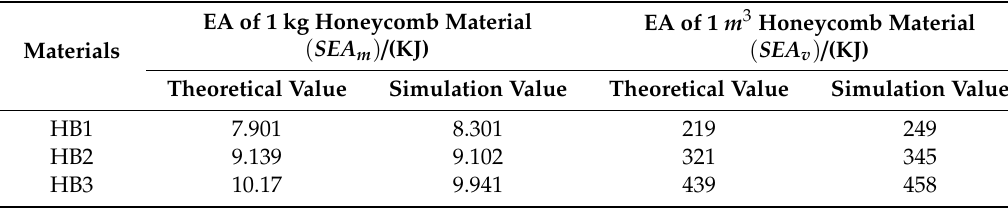
Table 4. Dynamic EA results of regular hexagon honeycomb structure.